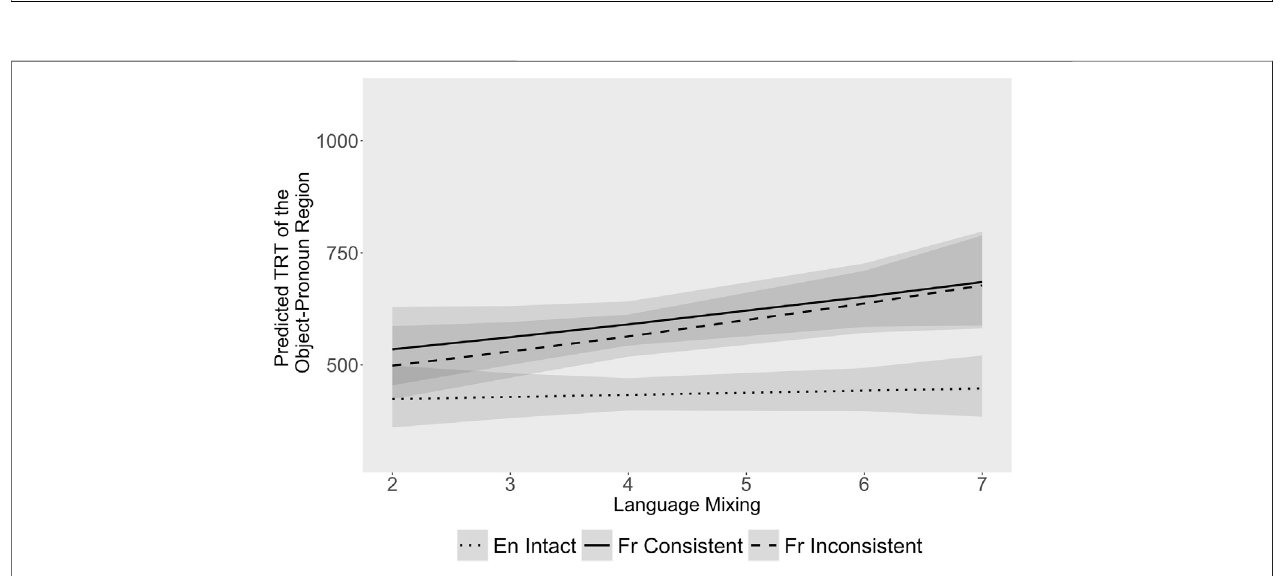
FIGURE 4 | Experiment 1 (French-English bilinguals reading in L2), interaction effect of language mixing (out of 7) on predicted total reading time (in ms) of the object-pronoun region. Shaded area represents plus/minus one standard error of the mean.